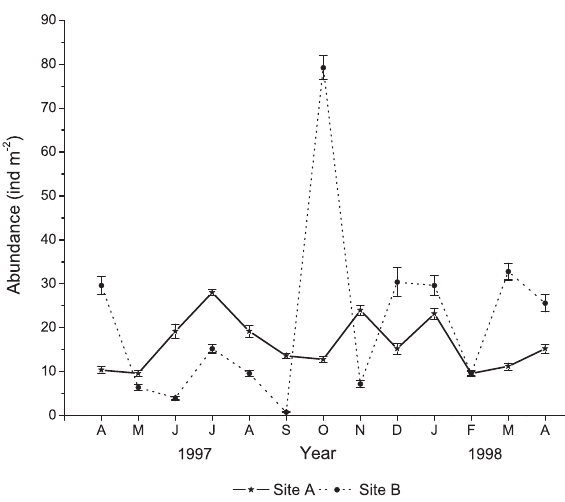
Figure 1. Tagelus plebeius . Temporal variation of abundance of live individuals (ind m - ²). Vertical bar: standard error.